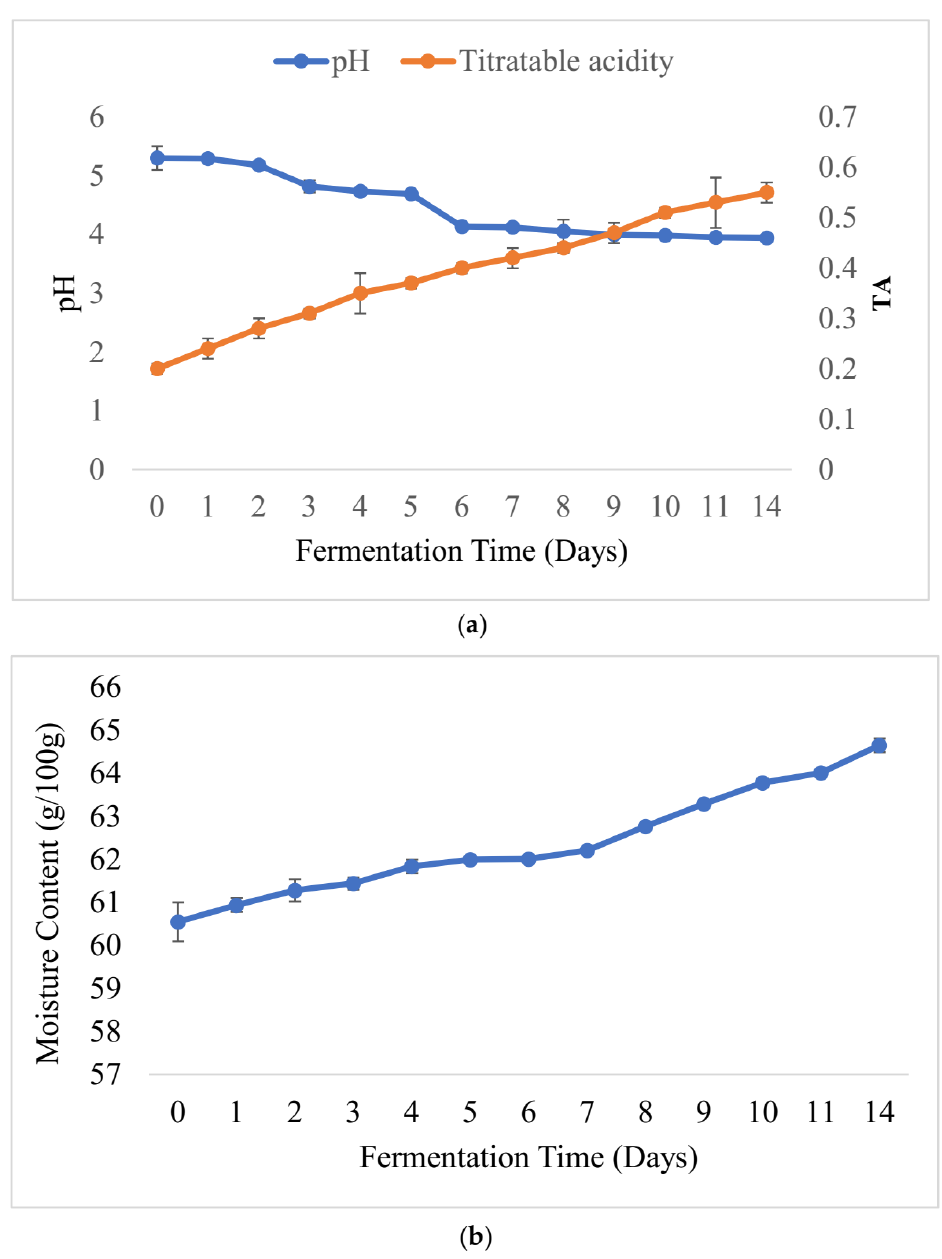
Figure 3. pH and TA values ( a ) and changes in the moisture content ( b ) of laboratory-prepared barley-based